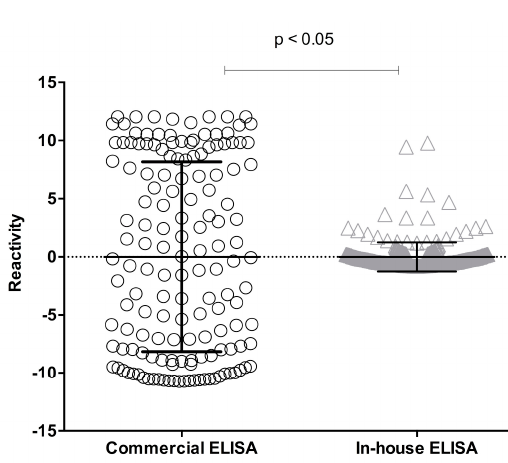
Figure 2. Comparison of serological reactivity between the two ELISAs. Serological reactivity of crude extract of P. falciparum to total anti- P. falciparum antibodies was evaluated by commercial and in-house ELISAs using sera from individuals exposed to Plasmodium sp. ( n = 365). Results were analyzed by Student’s t -test and have represented by whisker boxes, medians, and interquartile ranges, with a representation of the statistical value ( p <